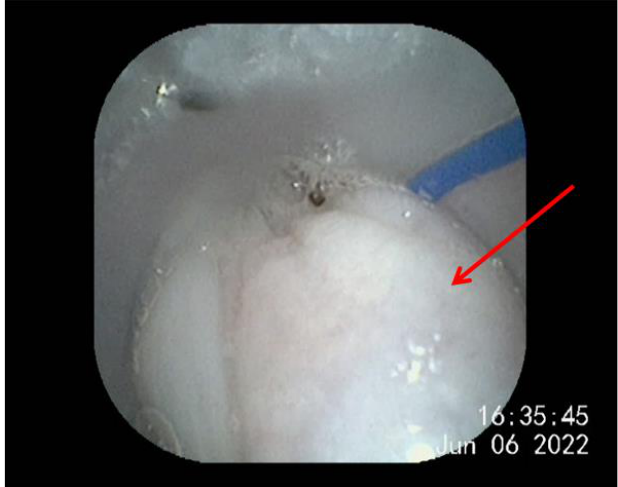
Figure 1. The conditions in the oral cavity of pangolins during isoflurane anaesthesia were observed by endoscope. The tongue was indicated by the arrow.